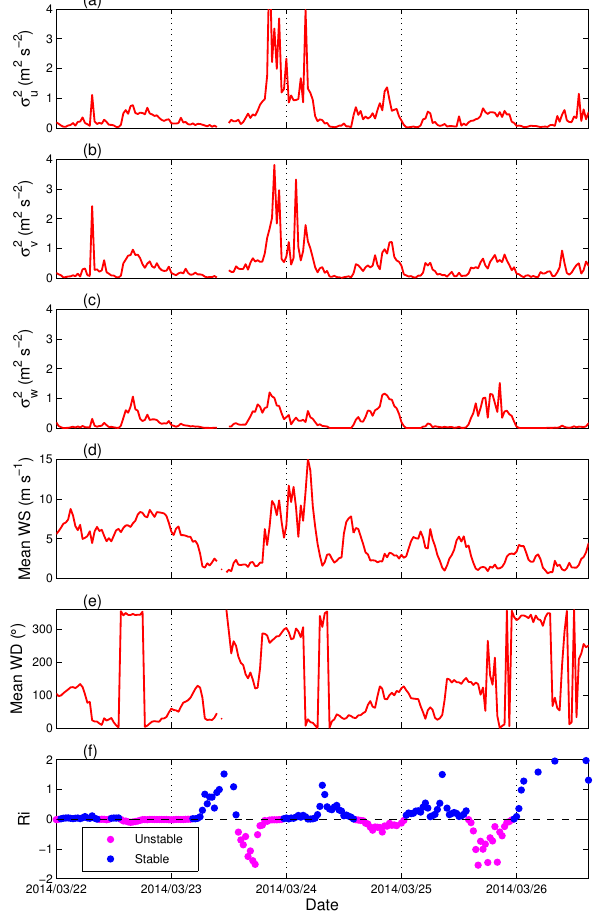
Figure 3. 30min (a) u variance, (b) v variance, (c) w variance, (d) mean wind speed, and (e) mean wind direction at 100m from sonic anemometers at BAO and (f) Richardson number calculated from tower data. Data are shown from 22 to 26 March 2014, and tick marks for each date correspond to 00:00UTC on that